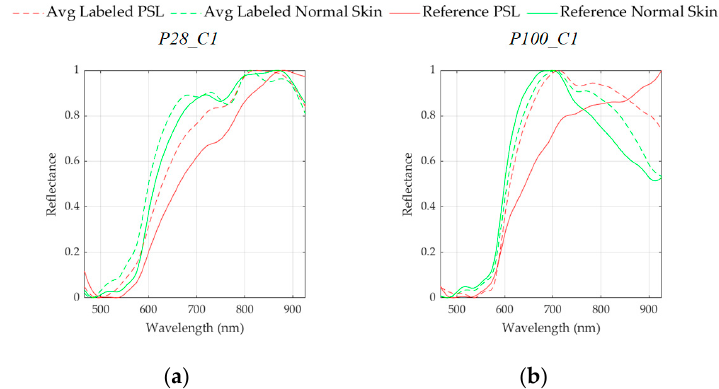
Figure 14. Average spectral signatures of the labeled PSL (dashed red line) and normal skin (dashed green line) pixels, and reference spectral signatures of PSLs (red line) and normal skin (green line). ( a ) P28_C1 (benign PSL). ( b ) P100_C1 (malignant PSL).